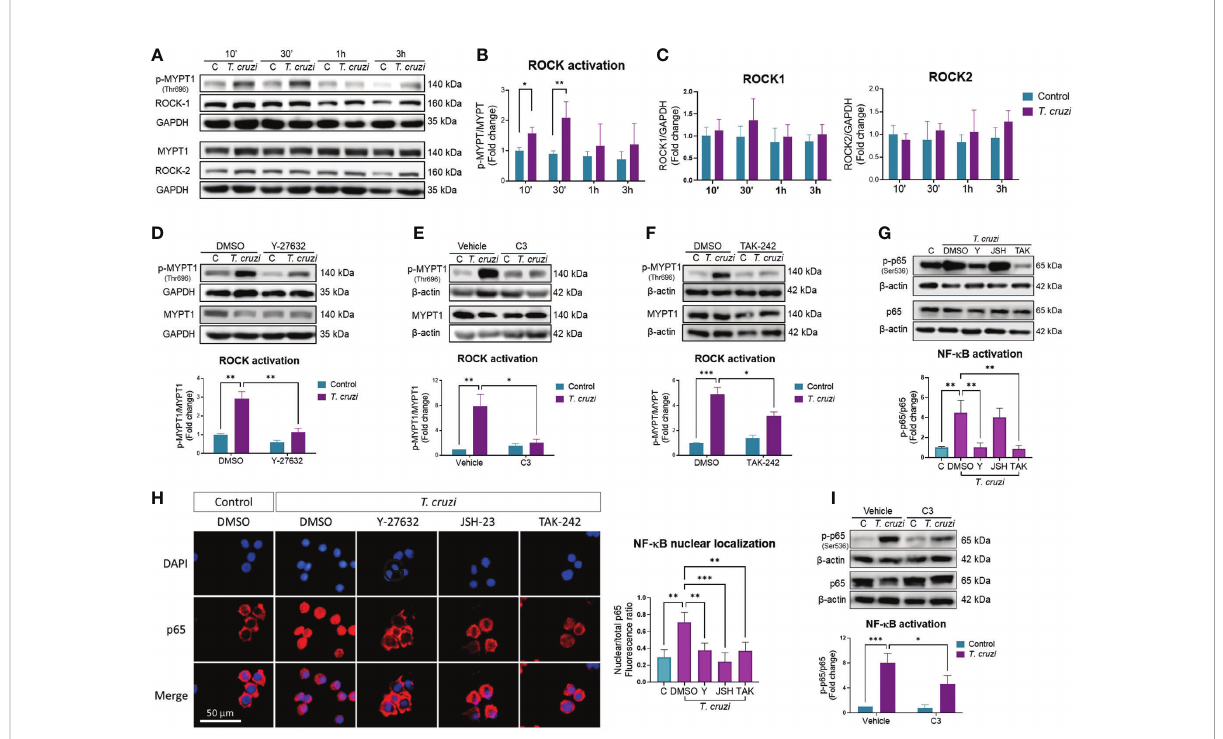
FIGURE 1 ROCK activation by T. cruzi mediates NF- k B activation via RhoA/TLR4 in human macrophages. PMA-induced U937 cells were incubated with or without T. cruzi trypomastigotes (MOI 1:1) for 10 min, 30 min, 1 h or 3 h. (A) Representative western blot. (B) ROCK activation was determined as the ratio of phosphorylated (p-MYPT1) to total MYPT1 (MYPT1), relative to control at 10 min. (C) ROCK-1 and ROCK-2 protein levels, relative to control at 10 min. (D) PMA-induced U937 cells were incubated with the ROCK inhibitor Y-27632 or vehicle (DMSO) for 60 min, and then incubated with or without T. cruzi for 30 min. ROCK activation was determined by western blot, as the ratio of p-MYPT1 to total MYPT1. (E) PMA-induced U937 cells were incubated with the RhoA inhibitor C3 exoenzyme (C3) or vehicle control (C3 buffer) for 24 h, and then incubated with or without T. cruzi for 30 min. ROCK activation was determined by western blot, as the ratio of p-MYPT1 to total MYPT1. (F) PMA-induced U937 cells were incubated with the TLR4 inhibitor TAK-242 or vehicle (DMSO) for 60 min, and then incubated with or without T. cruzi for 30 min. ROCK activation was determined by western blot, as the ratio of p-MYPT1 to total MYPT1. (G) PMA-induced U937 cells were incubated with Y-27632 (Y), JSH-23 (JSH), TAK-242 (TAK) or DMSO (vehicle) for 60 min, and then incubated with or without T. cruzi for 30 min. NF- k B activation was determined by western blot as phosphorylated (p-p65) to total p65 ratio. (H) Nuclear localization of p65 was determined by epi fl uorescence microscopy using anti-p65 antibody and DAPI for nuclear stain. P65 nuclear localization was quanti fi ed as the ratio between nuclear and total fl uorescence. (I) PMA-induced U937 cells were incubated with the RhoA inhibitor C3 exoenzyme (C3) or vehicle control (C3 buffer) for 24 h, and then incubated with or without T. cruzi for 30 min. NF- k B activation was determined by western blot as p-p65 to total p65 ratio. All data are expressed as mean ± SD of 3 independent experiments. *p<0.05, **p<0.01, ***p<0.001, analyzed by two-way ANOVA and Tukey